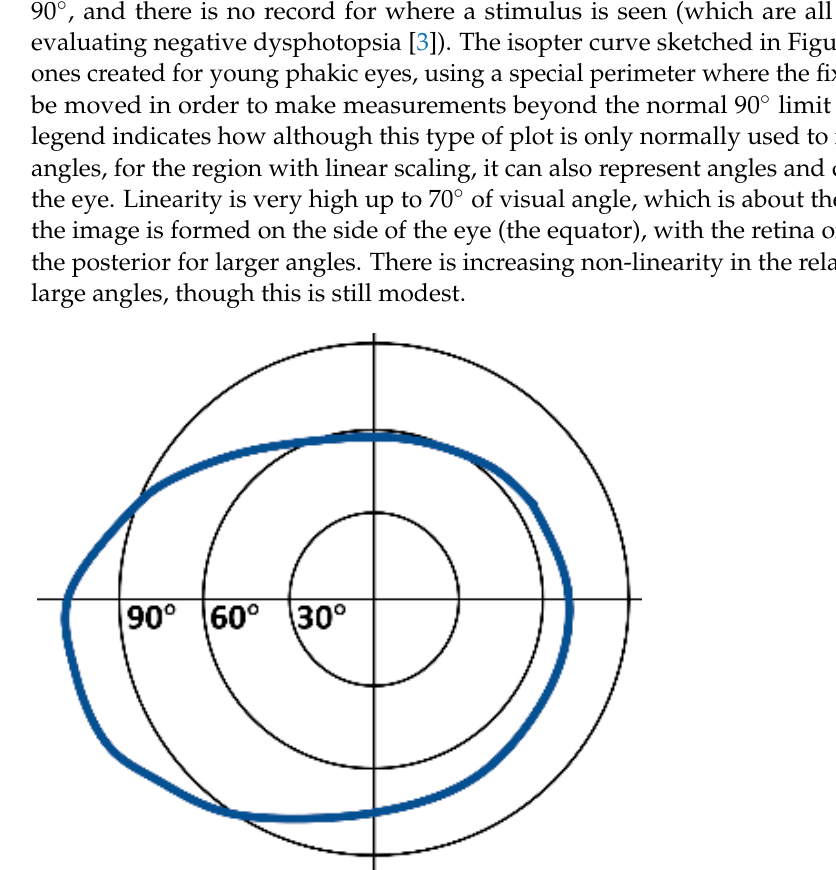
Figure 6. An isopter plot of visual thresholds for external targets. This might also represent internal angles at NP2, angles at the exit pupil (scaled by 1/0.83), or angles at the retinal center (scaled by 1/1.33) (and also distances along the retina if converted to arc lengths). A possible limiting isopter for a young phakic eye is sketched, exceeding the normal 90° limit of a perimeter [20].